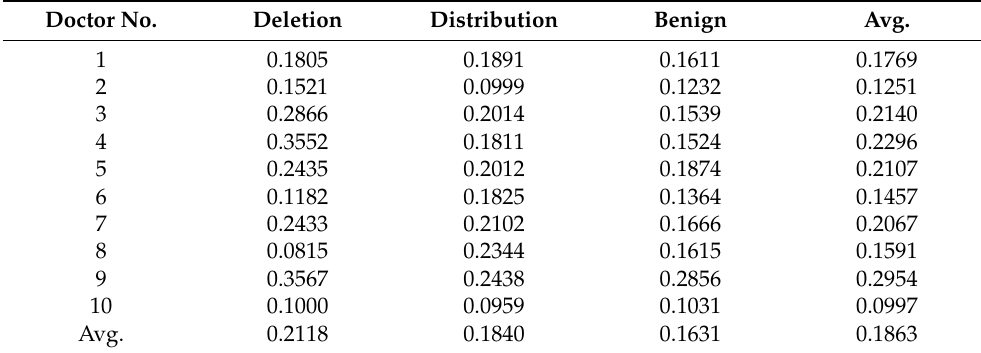
Table 8. MSEs for ten doctors under the three